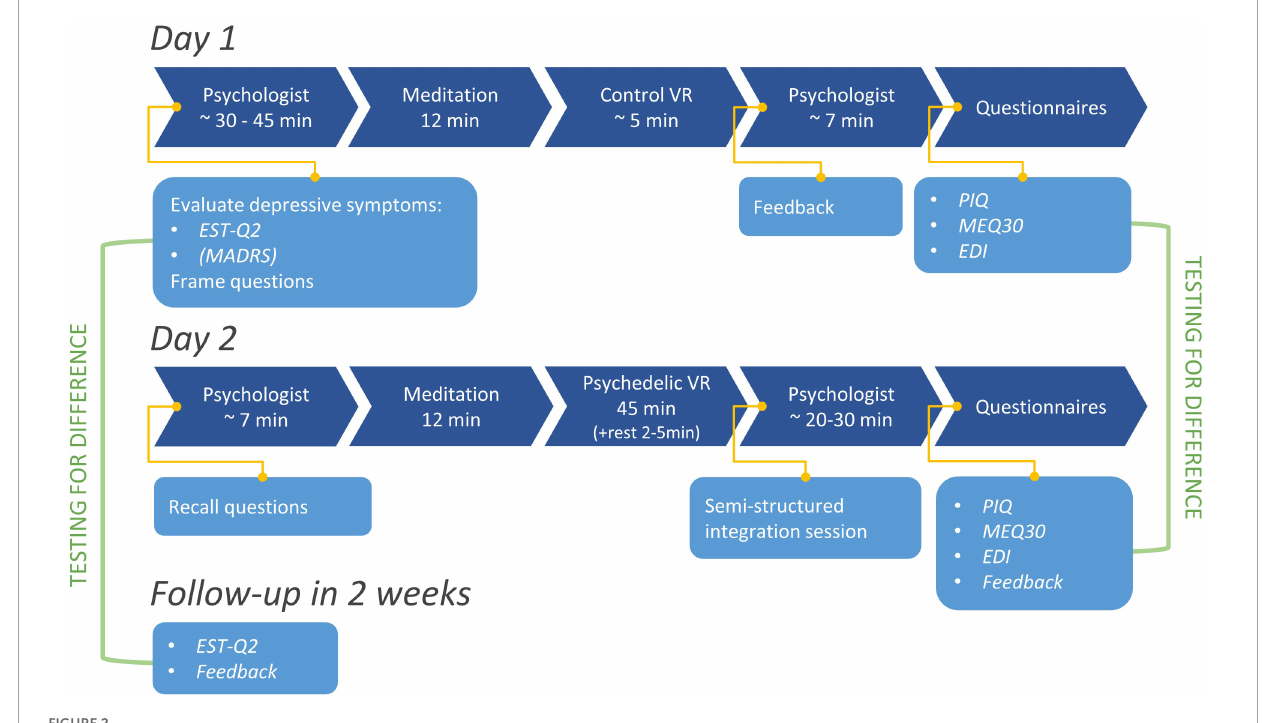
FIGURE2 An illustration of the procedure of the experiment on day 1 and day 2, as well as measurements conducted on the 2 days of experiments and during the follow-up after 2 weeks. The green lines highlight the comparison groups used for the statistical analyses.